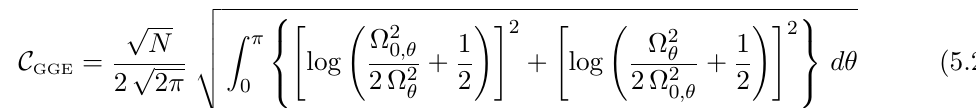
Figure 13 . Asymptotic value of C (right panel) as functions of ω 0 , for some values of ω